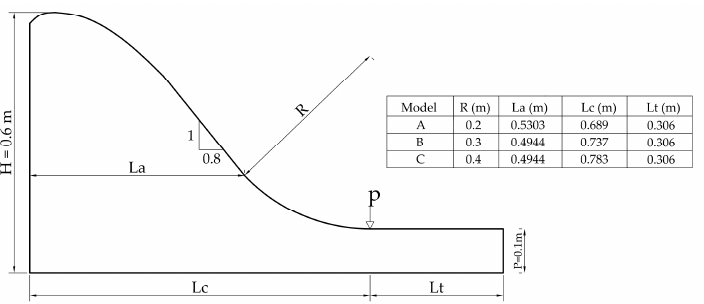
Figure 10. Outline of the geometric configuration used to obtain the chute characteristic curves using numerical modeling.